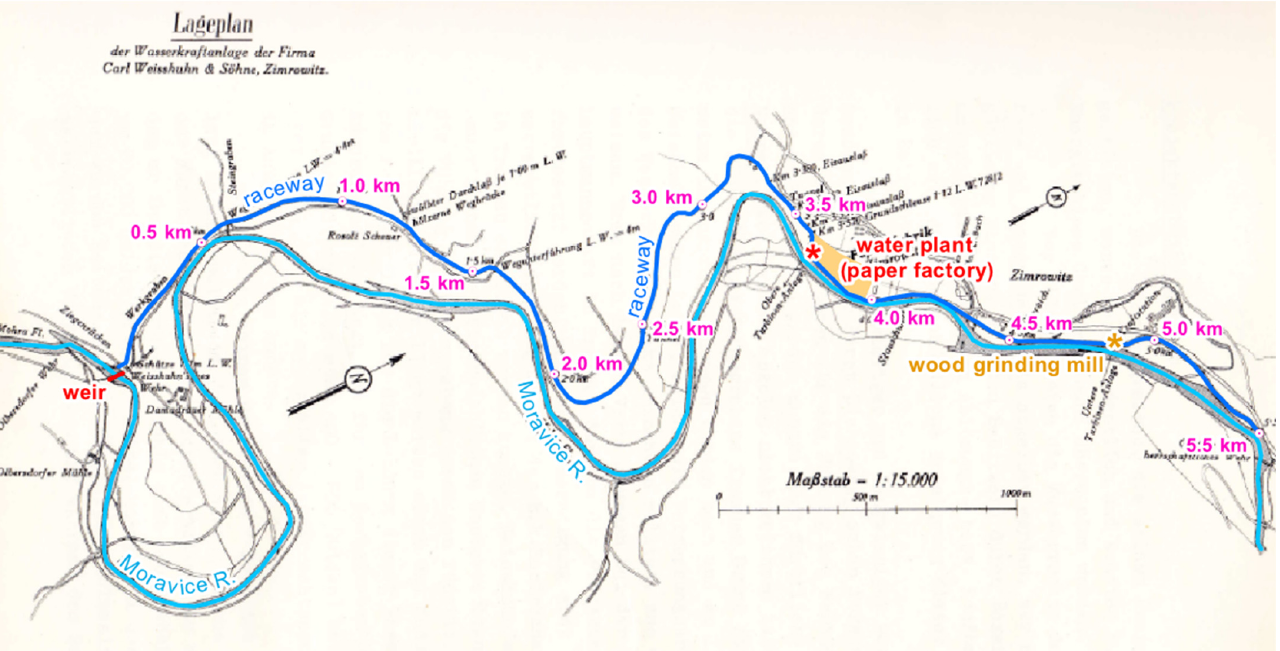
Figure 6. A plan of the raceway in Žimrovice with the position of the paper factory and water turbines (source: State District Archives in Opava, estate of Ladislav Sonnek).